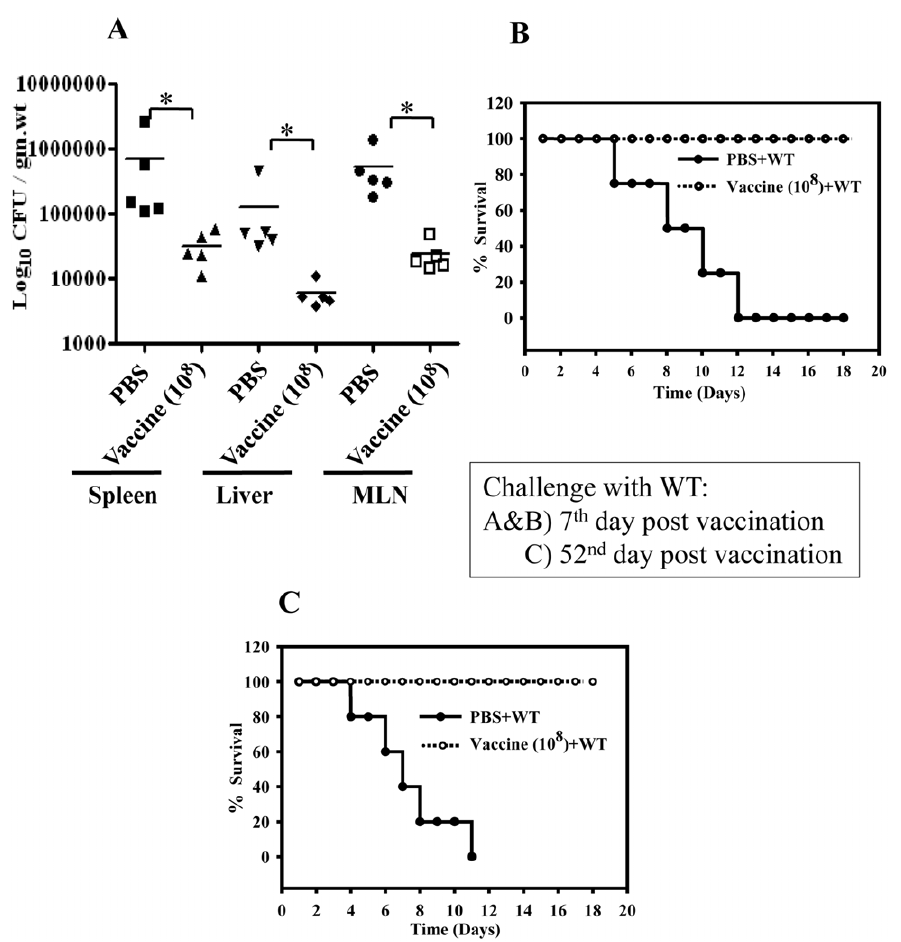
Figure 4. Single dose of vaccination imparts protection against WT Salmonella and induces long-term immunological memory. BALB/ c mice were vaccinated through oral route with 10 8 CFU of STM D hfq or PBS and challenged with either 10 7 CFU of WT for assessing organ load (A) or 10 8 of WT for assessing mortality (B). 7 days after challenge, mice were sacrificed and bacterial load was enumerated. For long-term immunological memory mice were challenged orally after 52 days of vaccination (C). Each group contains 5-6 mice. Statistical significance was defined as follows